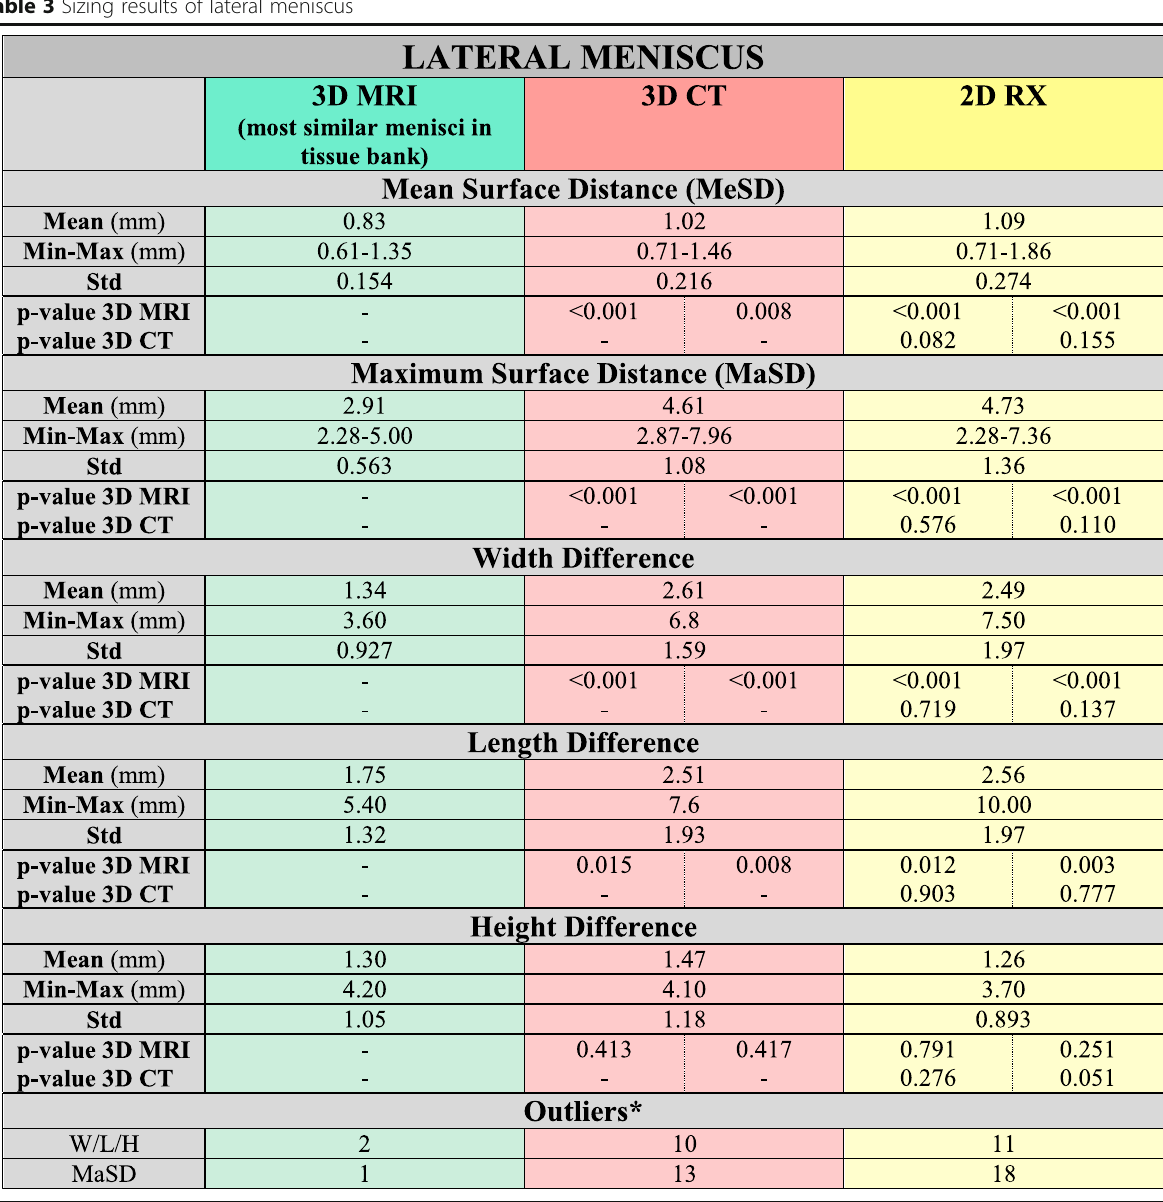
Table 3 Sizing results of lateral